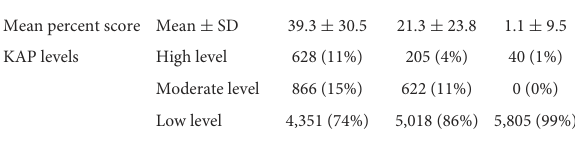
TABLE 3 The mean percent score for knowledge, attitude and